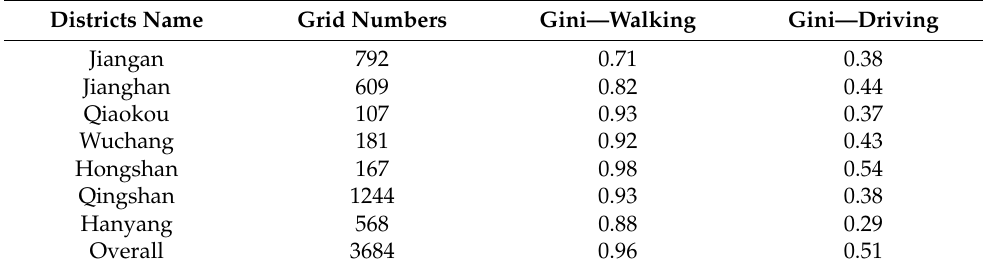
Table 2. Gini coefficients of different districts under two traffic modes.